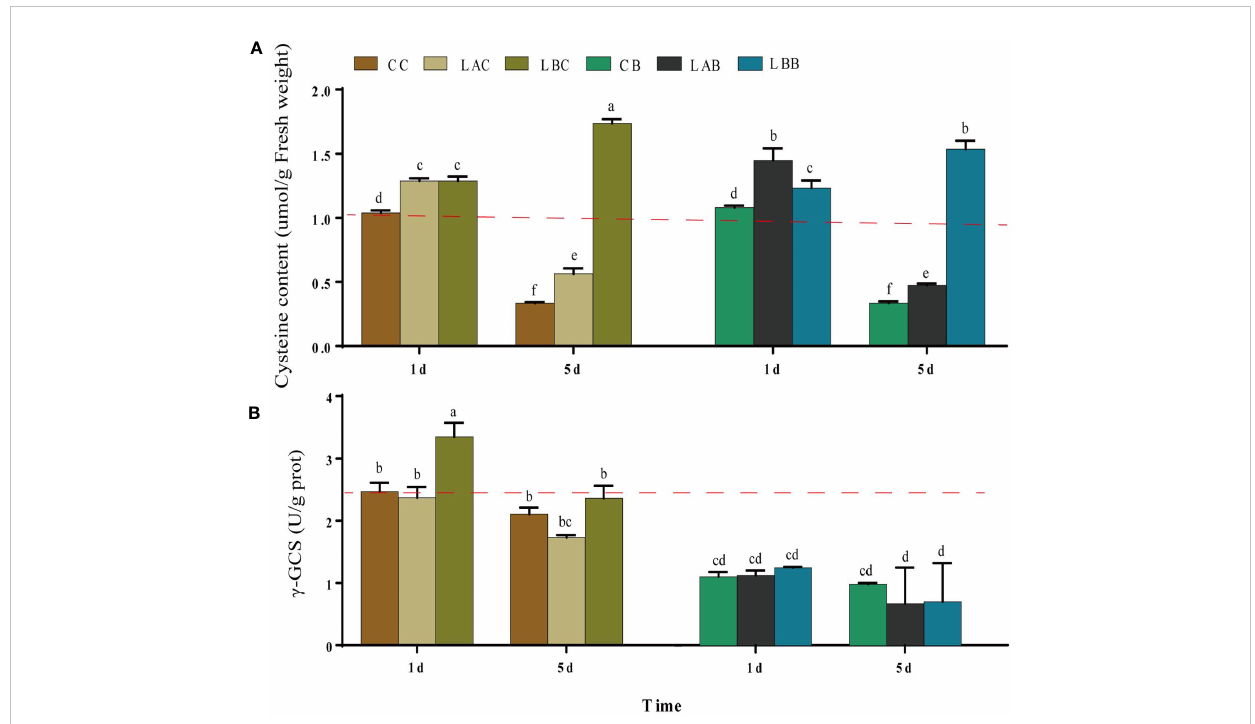
FIGURE 4 The (A) cysteine content and (B) g -glutamylcysteine synthetase ( g -GCS) activity in B fuscopurpurea under different culture conditions. Data was Mean ± SD (n = 3). Different letters indicated signi fi cant differences ( p < 0.05). The red dotted line indicates the level in the CC (100% seawater)